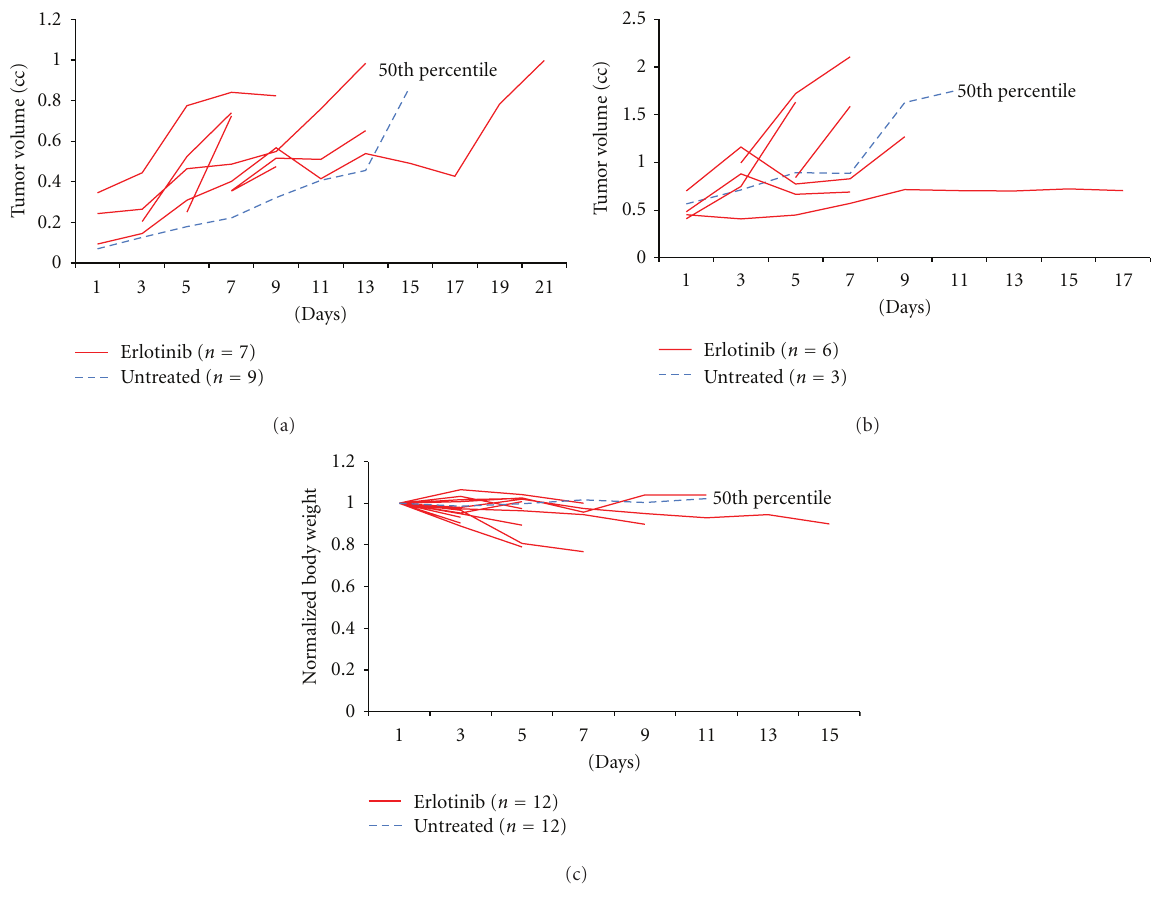
Figure 2: Tumor growth and weight loss in rhabdomyosarcoma-bearing mice treated with Erlotinib. (a) Tumor growth over time in mice which had tumors smaller than 0.4cc at diagnosis. The 50th percentile represents n = 9 control (untreated) tumor-bearing mice. (b) Tumor growth over time in mice which had tumors larger than 0.4cc at diagnosis. The 50th percentile represents n = 3 control (untreated) tumor- bearing mice. (c) Animal body weights over the duration of